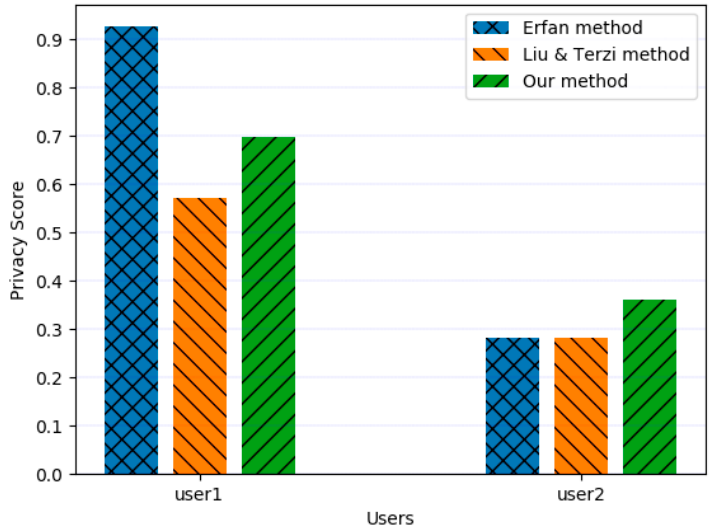
Figure 3. Experiment 1 privacy score.